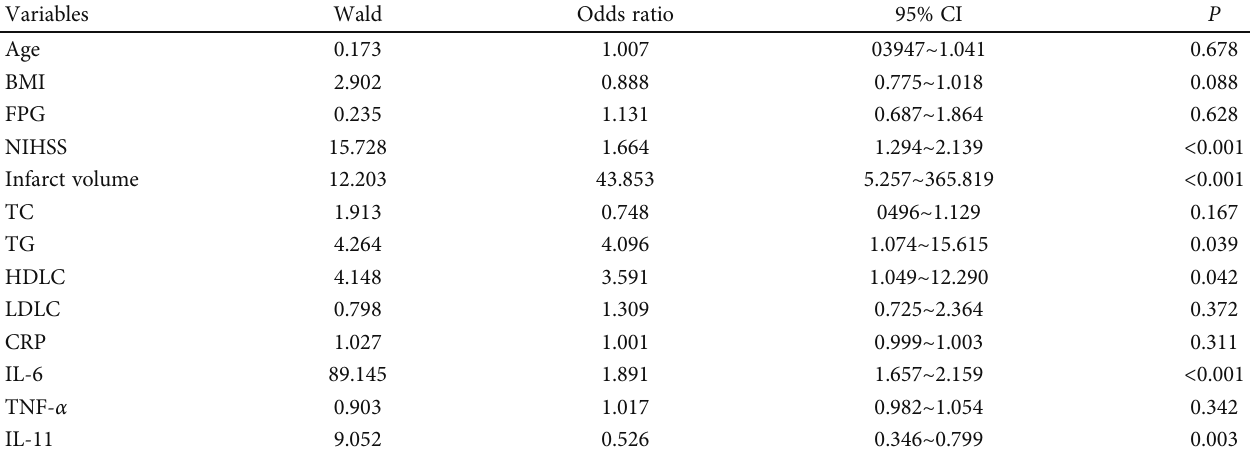
Table 4: Risk factors of ischemic stroke patients with bad prognosis by logistic regression